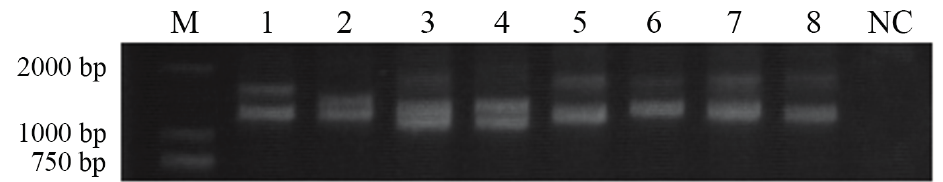
Figure 2. Electrophoresis patterns of MHC class II B partial DNA sequences in eight stone flounder individuals. Samples from eight individuals are labeled by numbers. NC is the PCR blank control without any template. More than one fragment between 1000 and 2000 bp was acquired from each of the eight DNA samples. The three fragments (2000, 1000 and 750 bp) in the marker (M) are marked on the